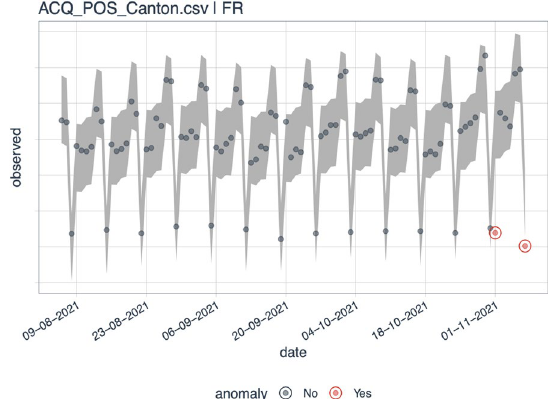
Fig. 3 Example of irregularity detection. Note : The figure displays the time series of cashless payments at PoS in the canton of Fribourg (between 09-08-2021 and 07-11-2021). The gray border indicates the confidence limits, while the dots represent observations of a single day. Red dots indicate irregularities: the one on 01-11-2021 is an economic irregularity due to a local holiday; the one on the far right is due to the late processing of transactions occurring on the last day of the sample (a Sunday), which was corrected in a subsequent data update. Data source: